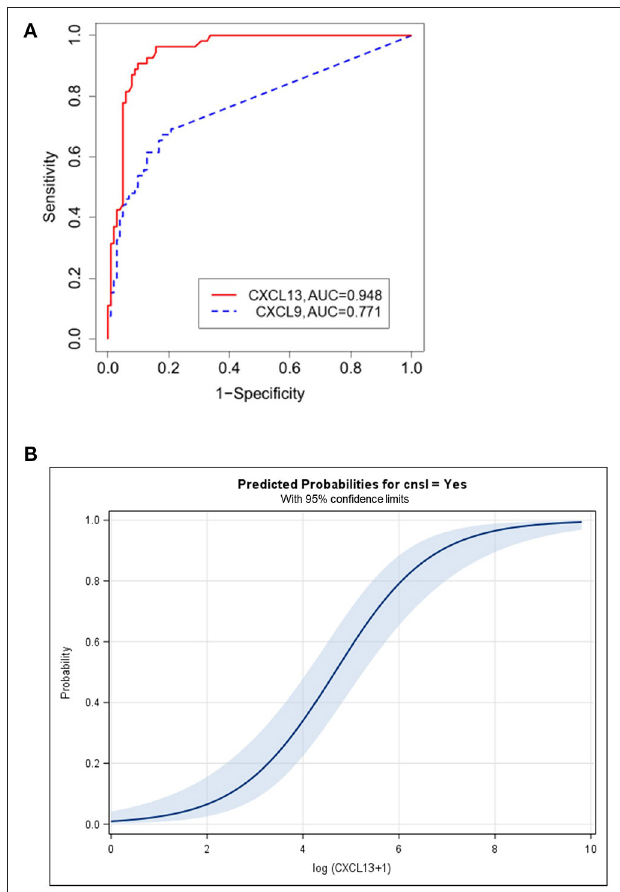
FIGURE 2 | (A) Diagnostic potential of CXCL13 and CXCL9. ROC-analysis of all 155 patients with cerebral focal lesions for CXCL13 (red line) and CXCL9 (blue line). AUC, Area under curve. (B) Probabilities for CNSL predicted by the logistic regression model. Each individual CXCL13 CSF level was transformed to LOGC, logarithm of [CXCL13 (pg/ml) + 1]. For each transformed LOGC, the linear predictor (LP) of the logistic regression model was calculated: LP